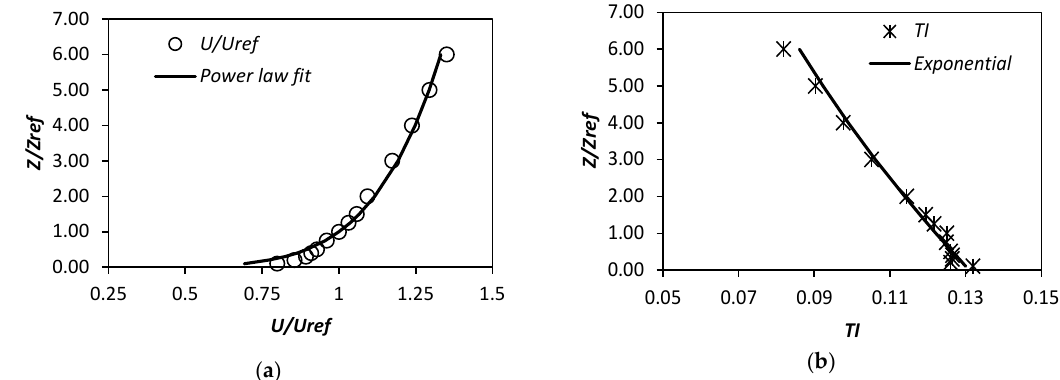
Figure 4. ( a ) Non-dimensional air velocity and ( b ) turbulence intensity profiles of the incident airflow inside wind tunnel.